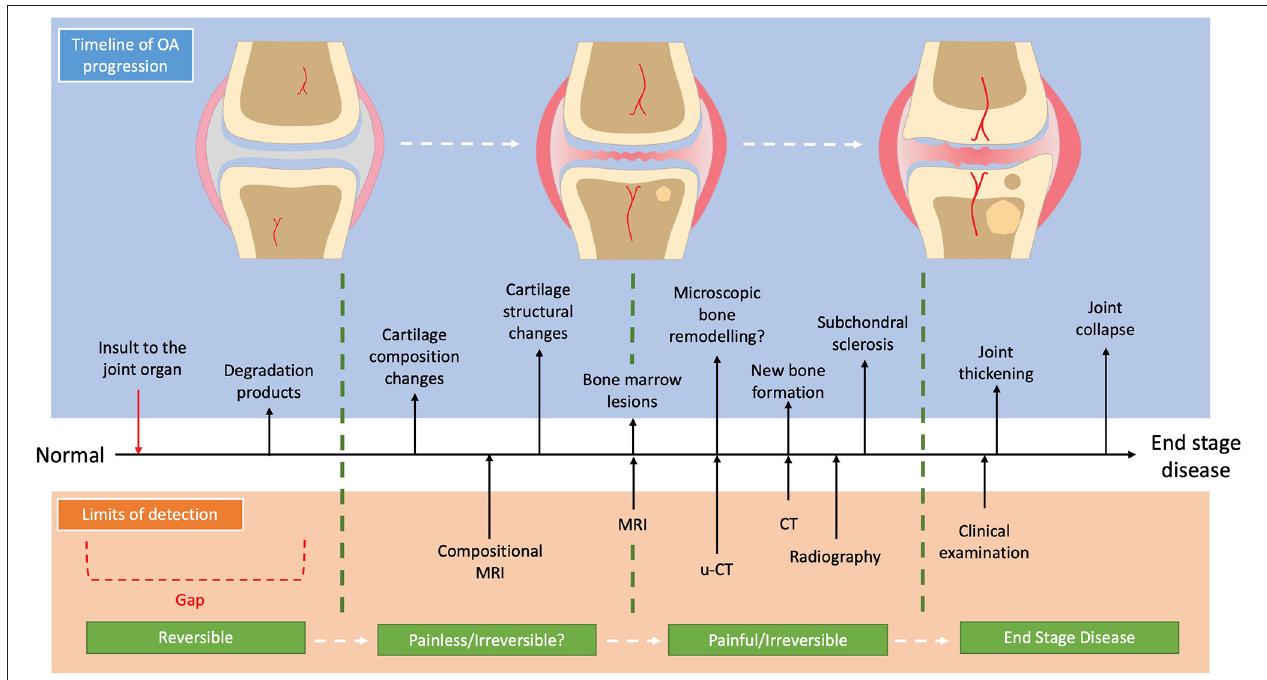
FIGURE 1 | Schematic progression of OA and the current detection limits with diagnostic imaging.